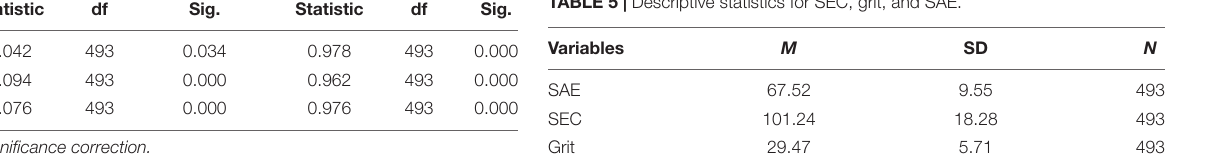
TABLE 5 | Descriptive statistics for SEC, grit, and